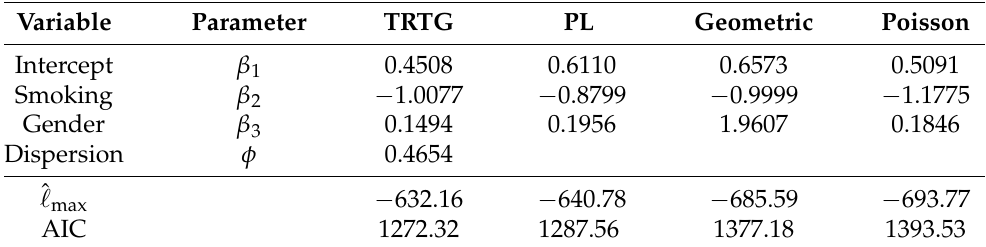
Table 8. Estimated parameters for the TRTG, Poisson, geometric, and PL regression models along (cid:16) (cid:17) ˆ (cid:96) with and max